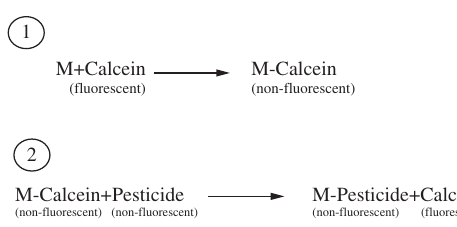
Figure 4 Schematic experimental setup of